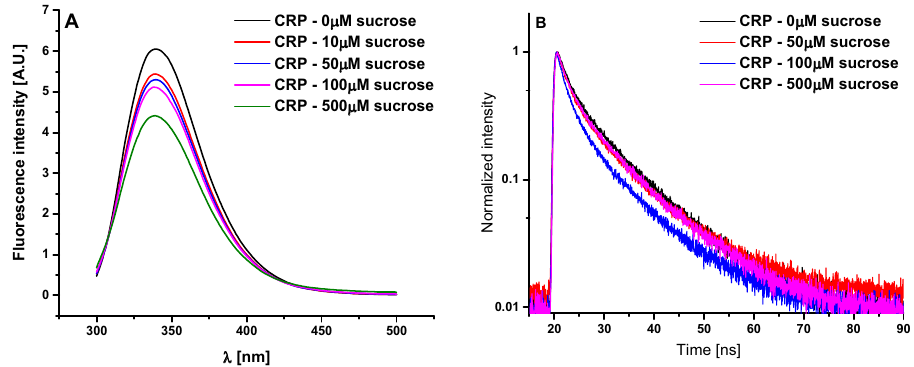
Figure 9. Fluorescence emission spectra for the sample containing CRP supplemented with different sucrose concentrations ( A ); Fluorescence lifetime spectra for the sample containing CRP supplemented with different sucrose concentrations ( B ).